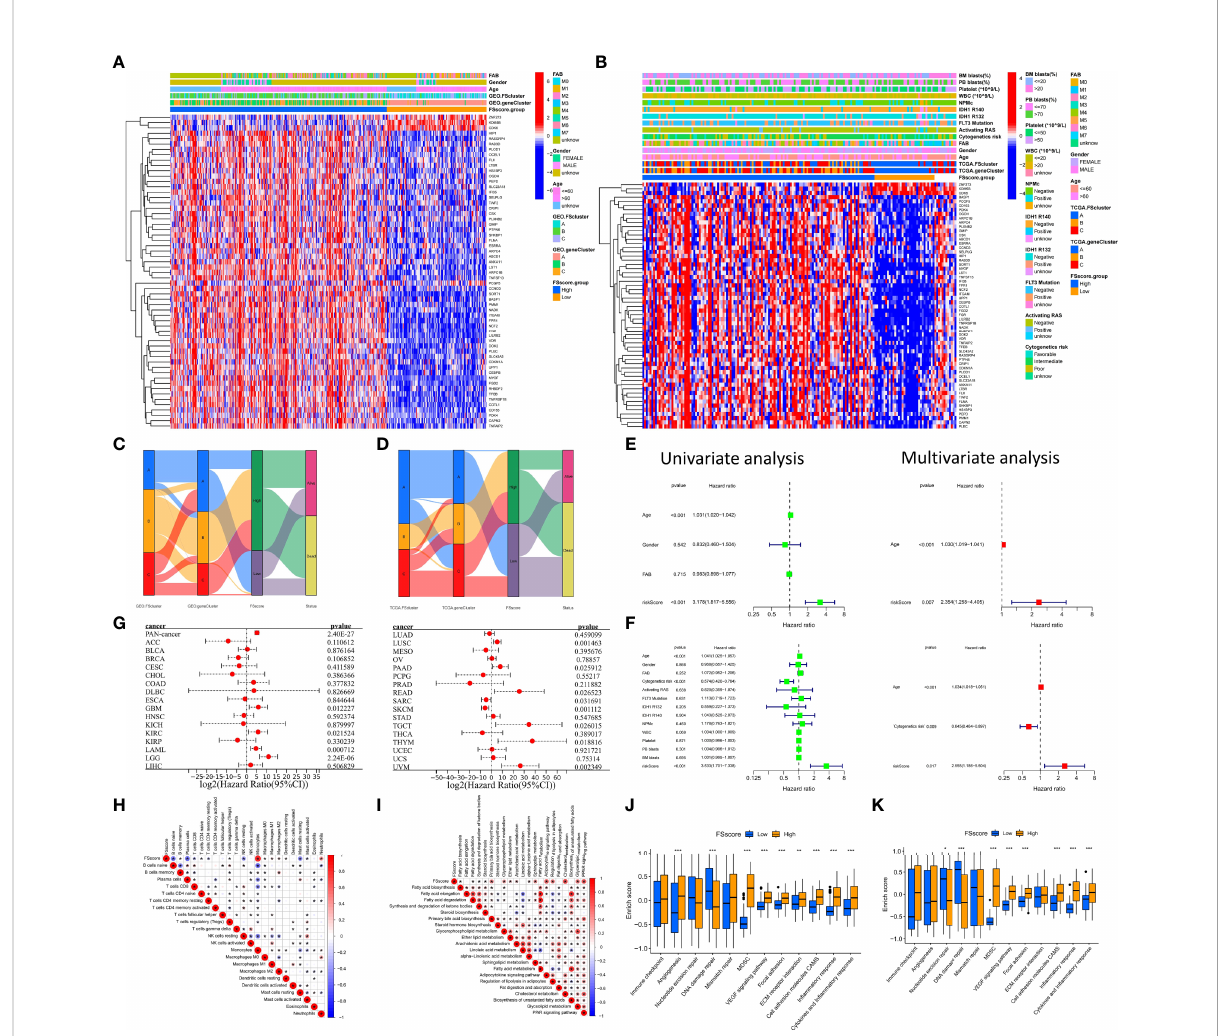
FIGURE 6 Distribution characteristics and prognostic value analysis of the FSscore, correlation analysis between characteristics of the TME and FSscore. (A, B) Differences in patient distribution, clinicopathological factors and phenotype signature gene expression of the high and low FSscore groups in the GEO and TCGA cohorts, the blank in the annotation of FSscore group in the TCGA cohort is due to the lack of clinical information of corresponding patients. (C, D) Alluvial diagram showing the changes in ferroptosis-related molecular patterns, genomic subtypes, FSscore and patient status. (E, F) Univariate and multivariate independent prognostic analysis of FSscore, E: GEO group, F: TCGA group. (G) Prognostic value of the FSscore in pancancer datasets. (H) Correlation analysis between the levels of TME cell in fi ltration and the FSscore in the GEO group. (I) Correlation analysis between levels of lipid metabolism and the FSscore in the GEO group. (J, K) Differences in pathway signatures related to tumor development and the in fi ltration level of MDSCs in the TME in the high and low FSscore groups. D: GEO group, E: TCGA group,